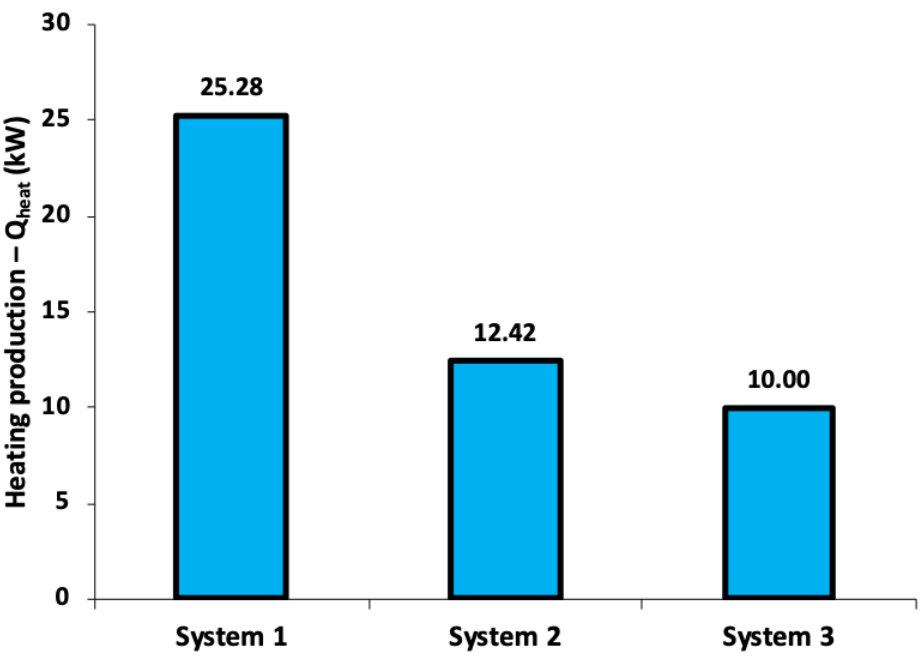
Figure 14. Heating production of the examined systems.